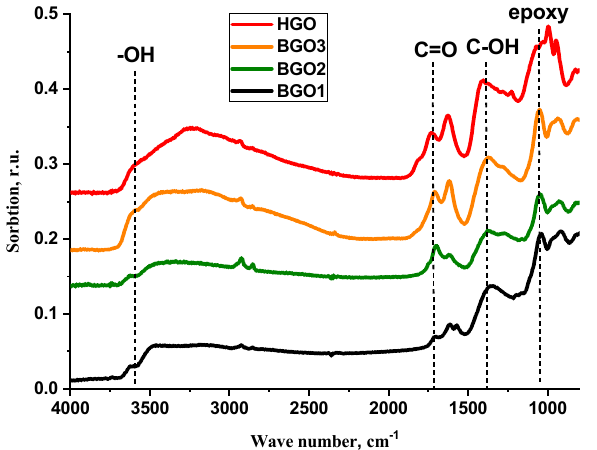
Figure 2. IR spectra of HGO (9:1) and BGO